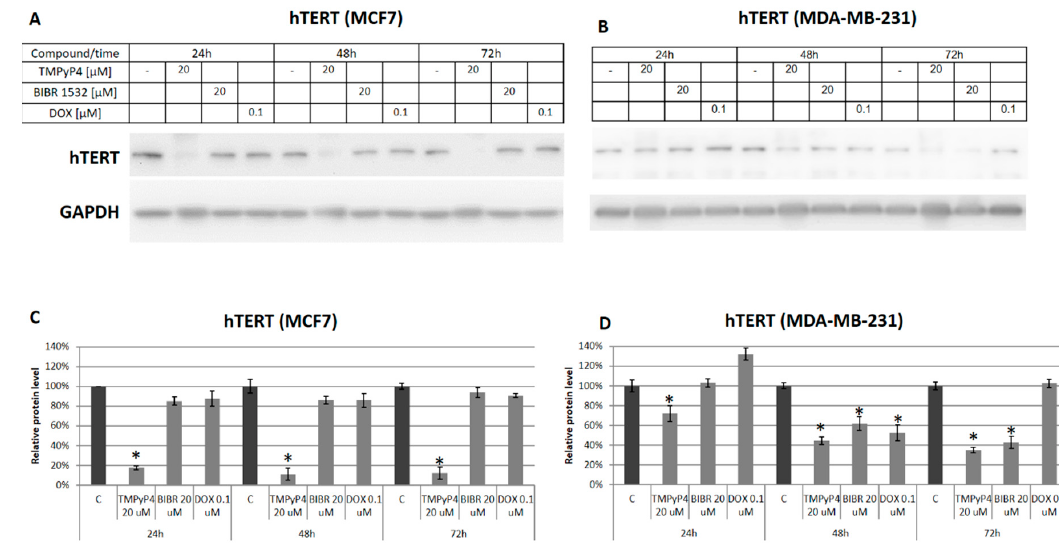
Figure 3. TMPyP4 efficiently decreases hTERT accumulation in a time-dependent manner. MCF7 ( A ) and MDA-MB-231 ( B ) cells were subjected to treatment with TMPyP4 (20 µM), BIBR 1532 (20 µM) or DOX (0.1 µM) in a time-course experiment. After individual time intervals (24, 48, or 72 h) cells were lysed, and immunoidentification of hTERT was performed. The concentration of compounds was adjusted according to MTT assay. GAPDH was used as a loading control. Densitometry analysis of the western blot results was performed relative to the loading control, GAPDH ( C , D ). * p < 0.05, relative to control sample.